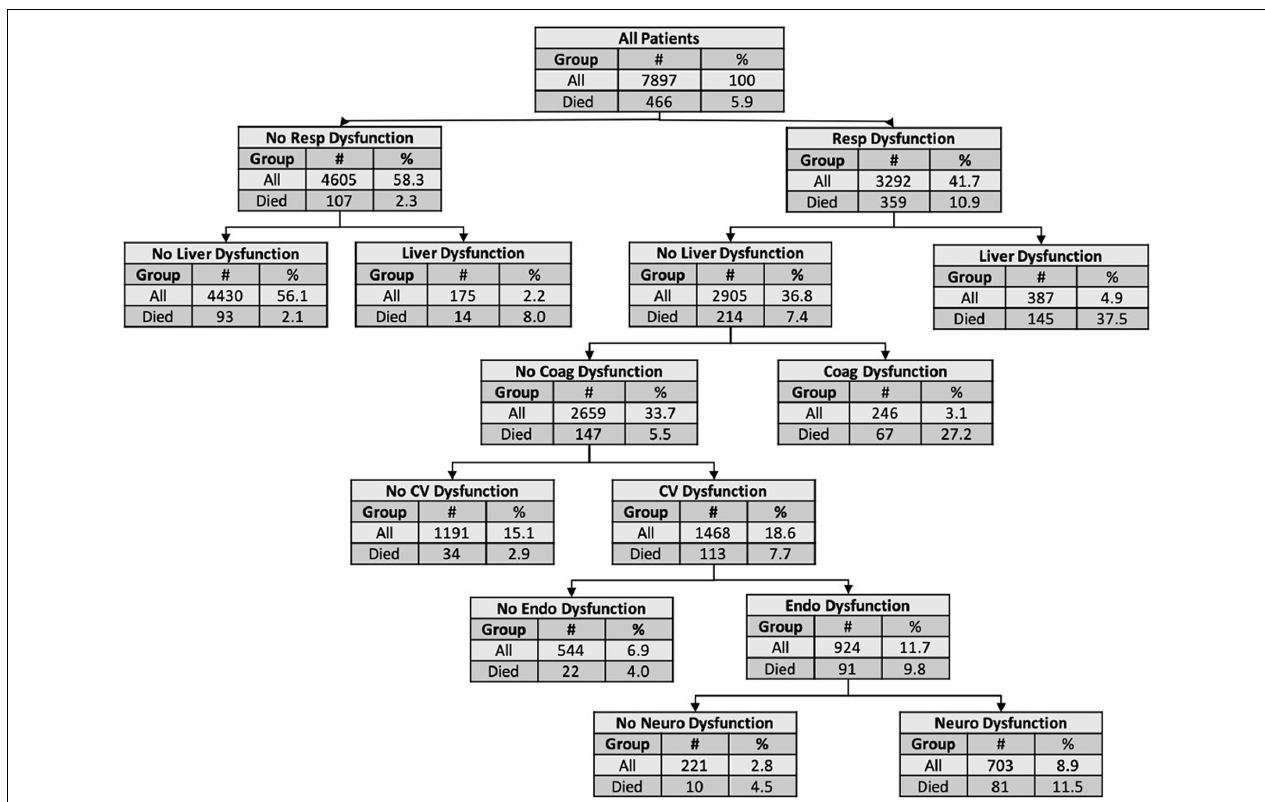
FIGURE 3 | Classification and regression tree for mortality. The nodes and leaves were based on 10-fold cross validation in the derivation set but the numbers presented are for the entire cohort. The top node of the decision tree (the root node) shows the total number of subjects in the cohort and the number and proportion of non-survivors. Each subsequent node shows the criterion for subsequent decisions, along with the number and proportion of patients with or without the organ dysfunction and the proportion who died. Terminal nodes show the risk for an individual with the preceding organ dysfunctions. AUROC: 0.75 (95% CI 0.69–0.82). Coag, coagulation; CV, cardiovascular; Endo, endocrinologic; Neuro, neurologic; Resp,